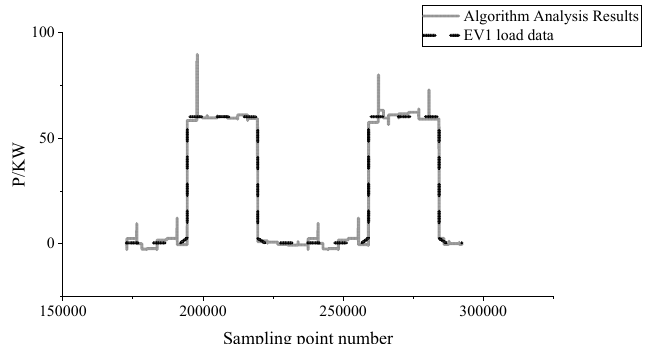
Figure 8. Decomposition result of deep neural network on EV1 of electric vehicle charging station with no new load.